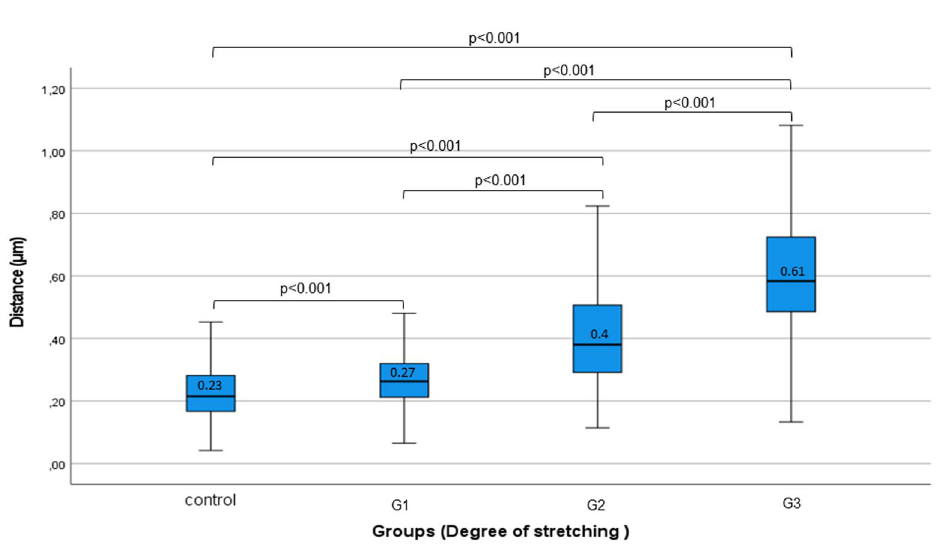
Figure 8. Distance between myofibrils. Boxplot diagram of measured distance between myofibrils. Paired comparisons of Groups demonstrated significant difference in between all of